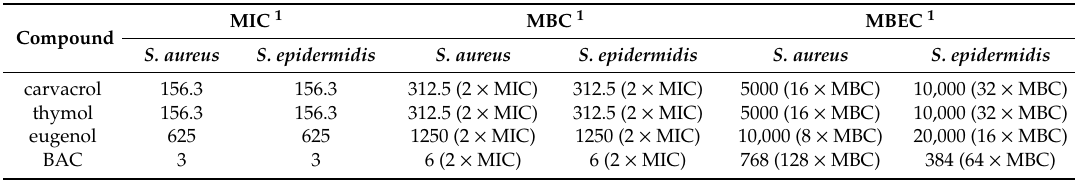
Table 2. MICs, MBCs and MBECs of each compound against each bacterial species.